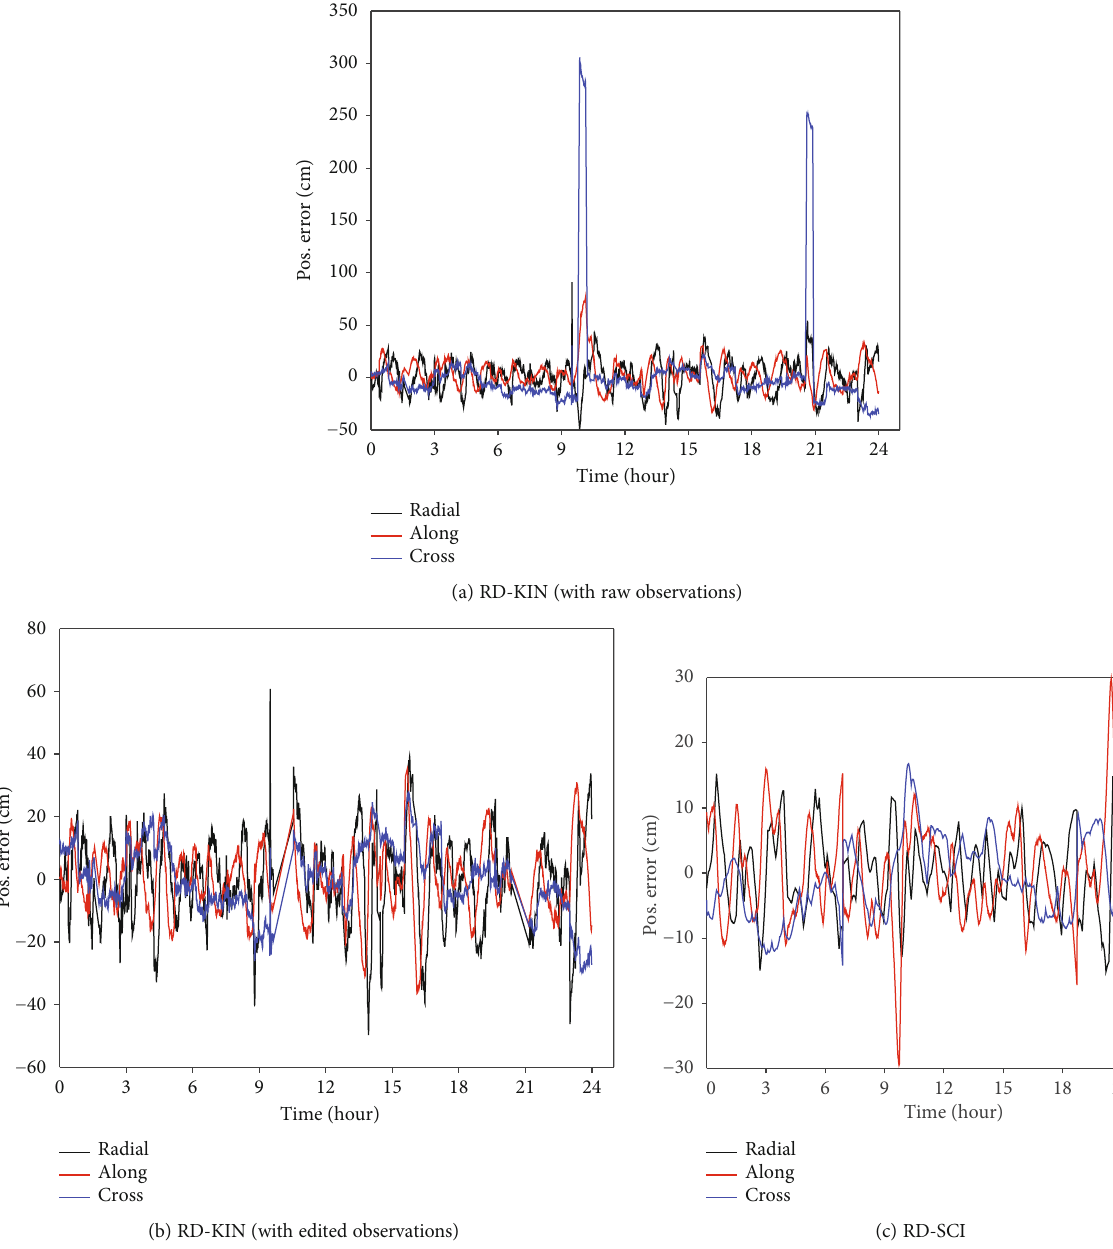
Figure 6: Position errors of the KOMPSAT-5 satellite in the radial, along-track, and cross-track directions on 14 July